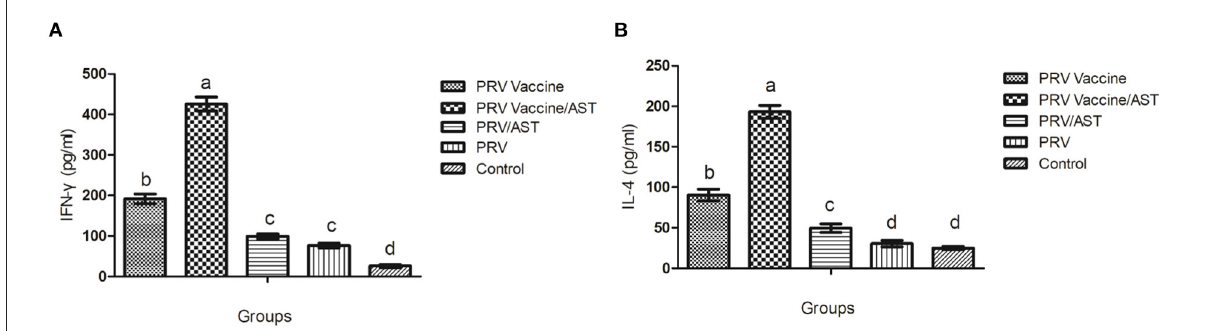
FIGURE3 Production of IFN- γ (A) and IL-4 (B) by splenocytes. At 28 dpi, mice from each group ( n = 5) with different treatments were euthanized, and the splenocytes were stimulated with inactivated PRV antigen. After 48h, the concentrations of IL-4 and IFN- γ in the supernatants were tested by commercial ELISA kits. The values represent the mean ± S.D ( n = 5). Bars with different letters indicate significant differences ( p < 0.05).